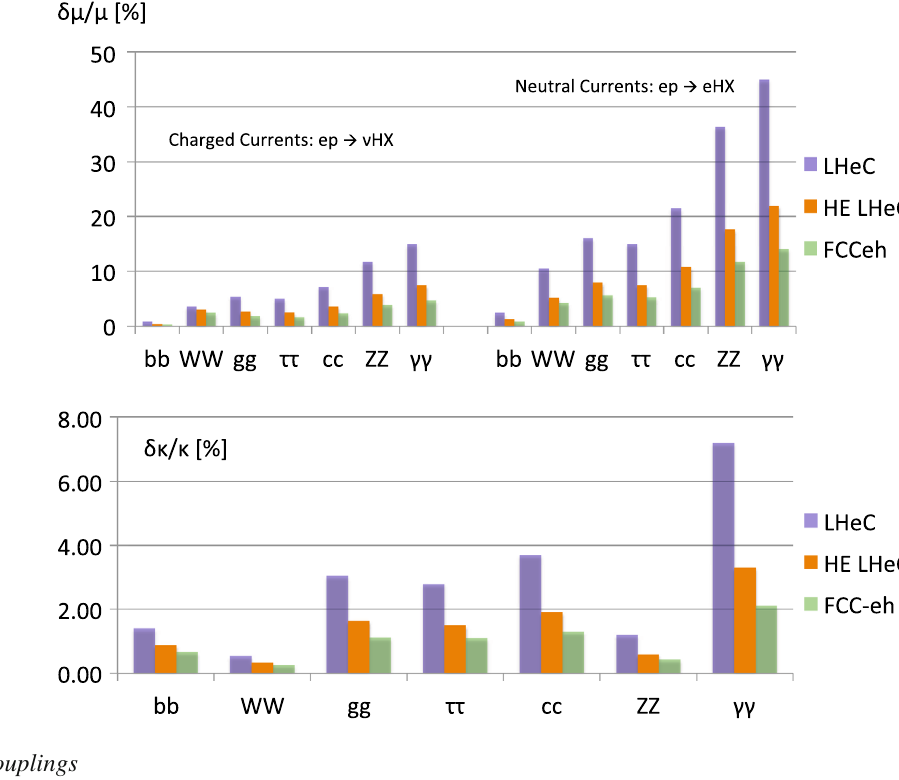
Fig. 4.12 Determination of the κ scaling parameter uncertainties, from a joint SM fit of CC and NC signal strength results for the FCC-eh (green, 2ab − 1 ), the HE LHeC (brown, 2ab − 1 ) and LHeC (blue, 1ab − 1